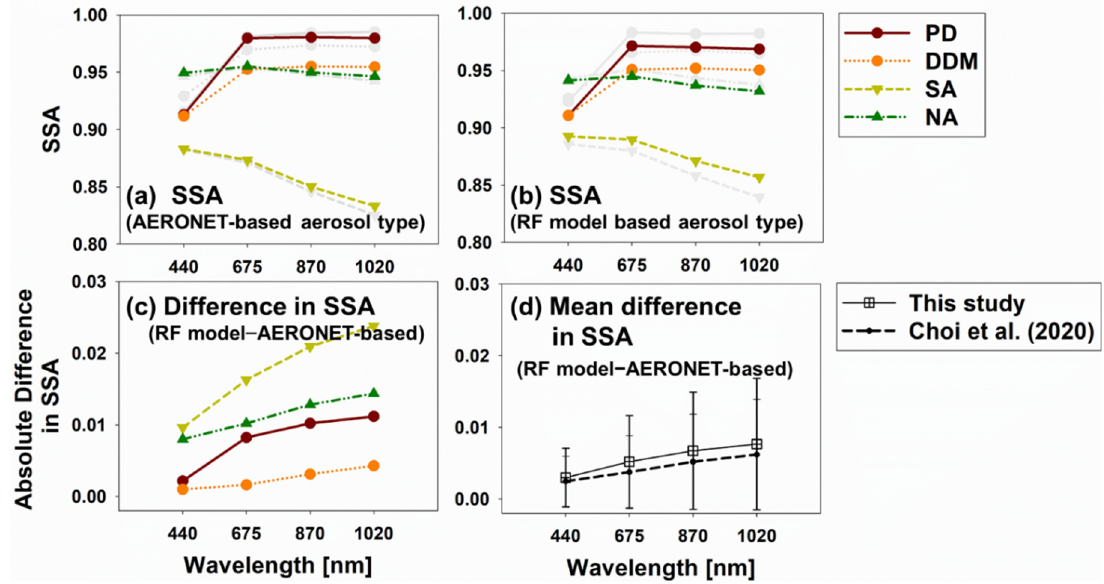
Figure 4. Wavelength dependence of single-scattering albedo (SSA) at 440, 675, 870, and 1020 nm for ( a ) AERONET aerosol types and ( b ) RF aerosol types (this study); ( c ) the absolute difference in SSA for each aerosol type; ( d ) average differences in SSA. Error bars represent the standard deviation of the SSA difference. The gray-colored graphs indicate the values suggested by Choi et al. [25].